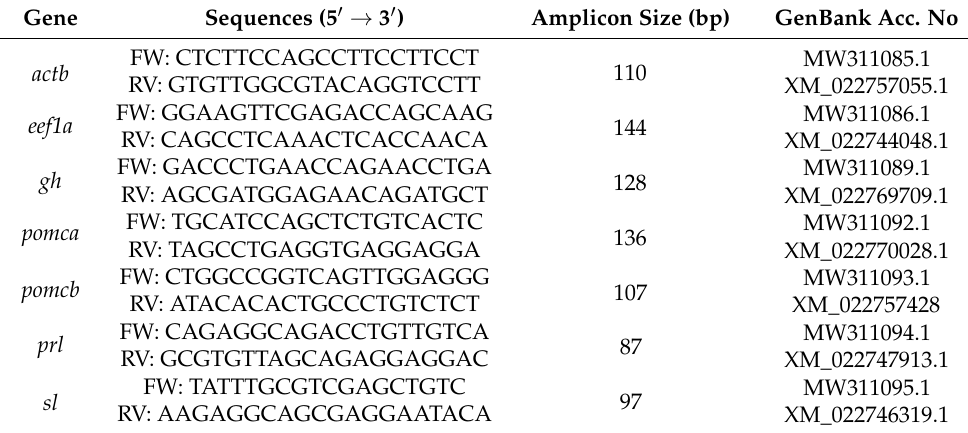
Table 1. Specific primers used for real-time qPCR expression analyses, sizes of the amplified products, and GenBank accession numbers for respective